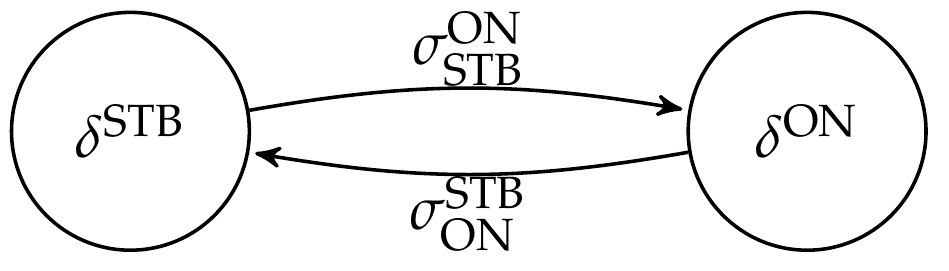
sketch of the addressed scenario. ELY stands for “electrolyzer ” and FC stands Figure 2. Simplified for “fuel cell”. Figure 3. Two-state automaton for a generic device. The electrolyzer and the fuel cell operations are modeled according to two corresponding different instances.